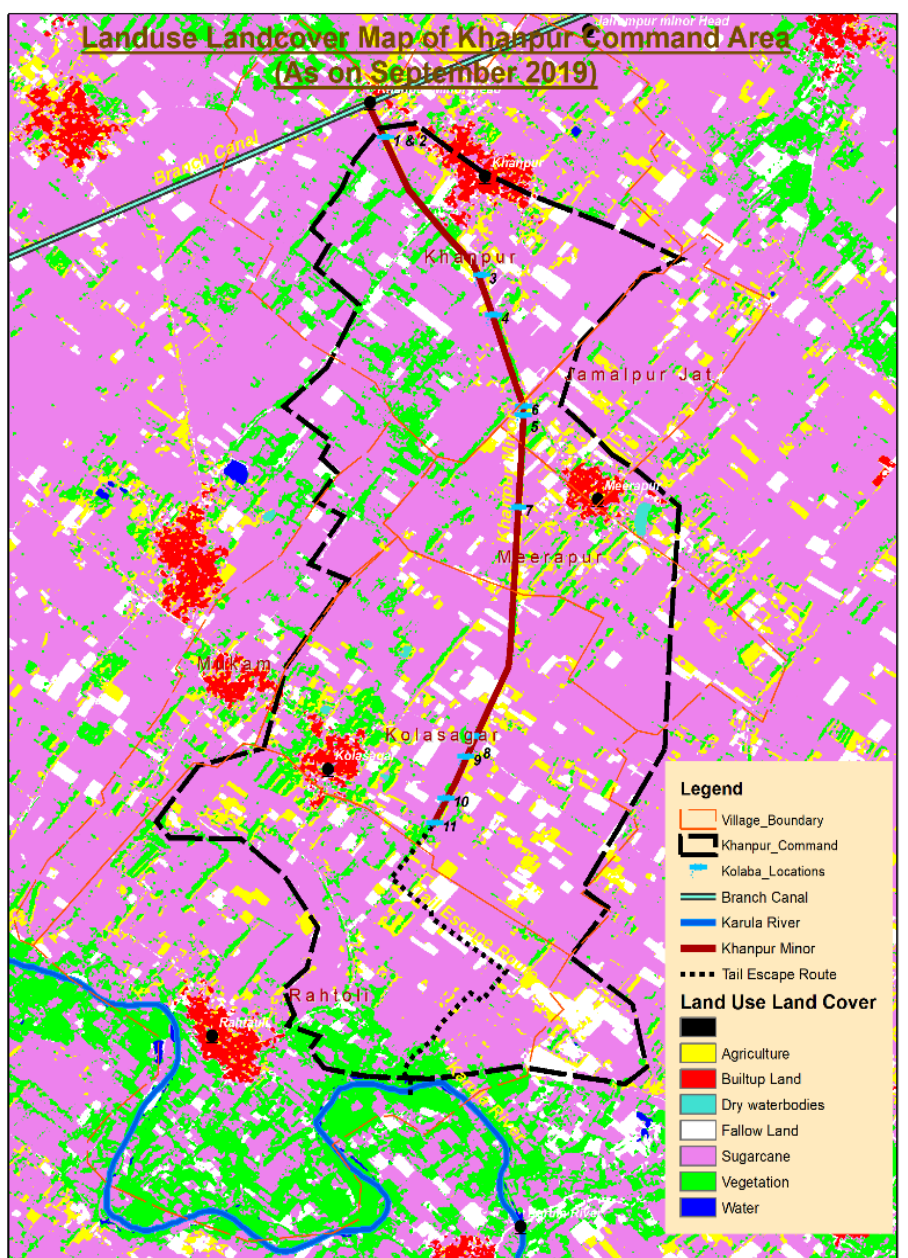
Figure A2. Land ‐ use Map of Khanpur Minor canal command area. Figure A1. Land-use Map of Khanpur Minor canal command